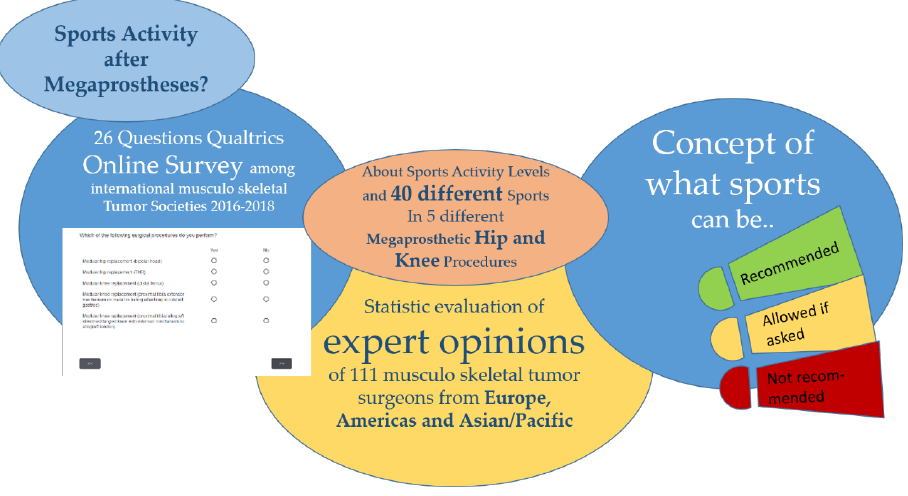
Figure 5. Graphical abstract of the Mo(dular) Re(placement) Sports Survey.